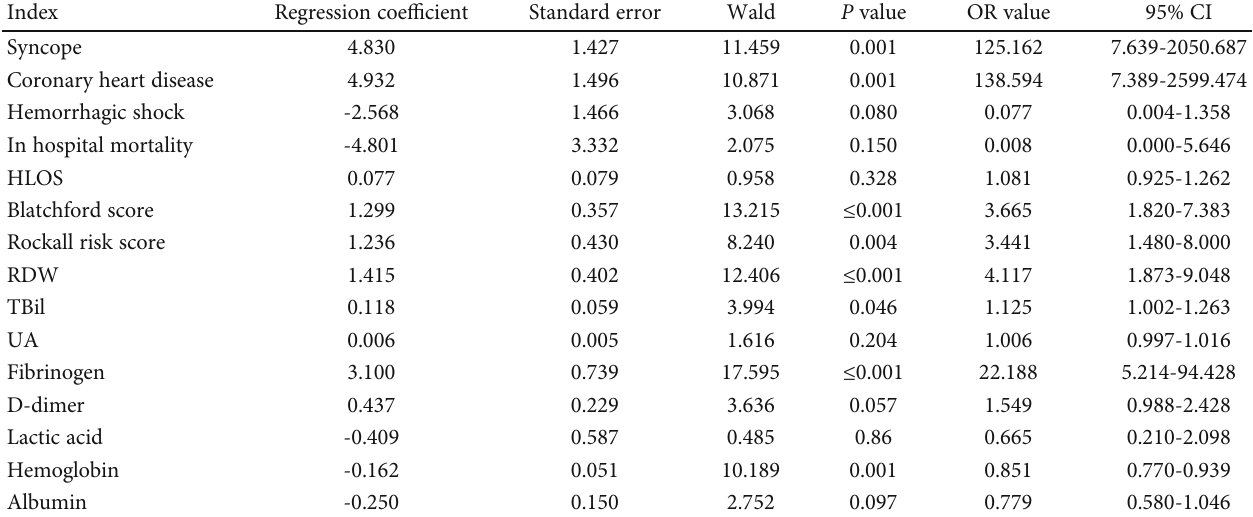
Table 2: Logistic regression analysis of relative indexes for ACS in UGIB patients adjusted by the history of coronary heart